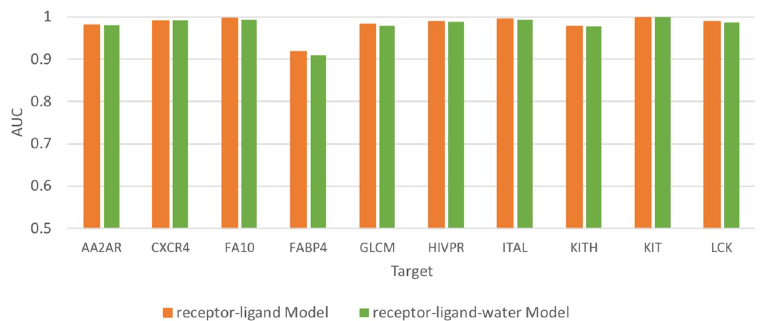
Fig 3. The performance of receptor-ligand and receptor-ligand-water CNN models in 10 DUD-E targets.